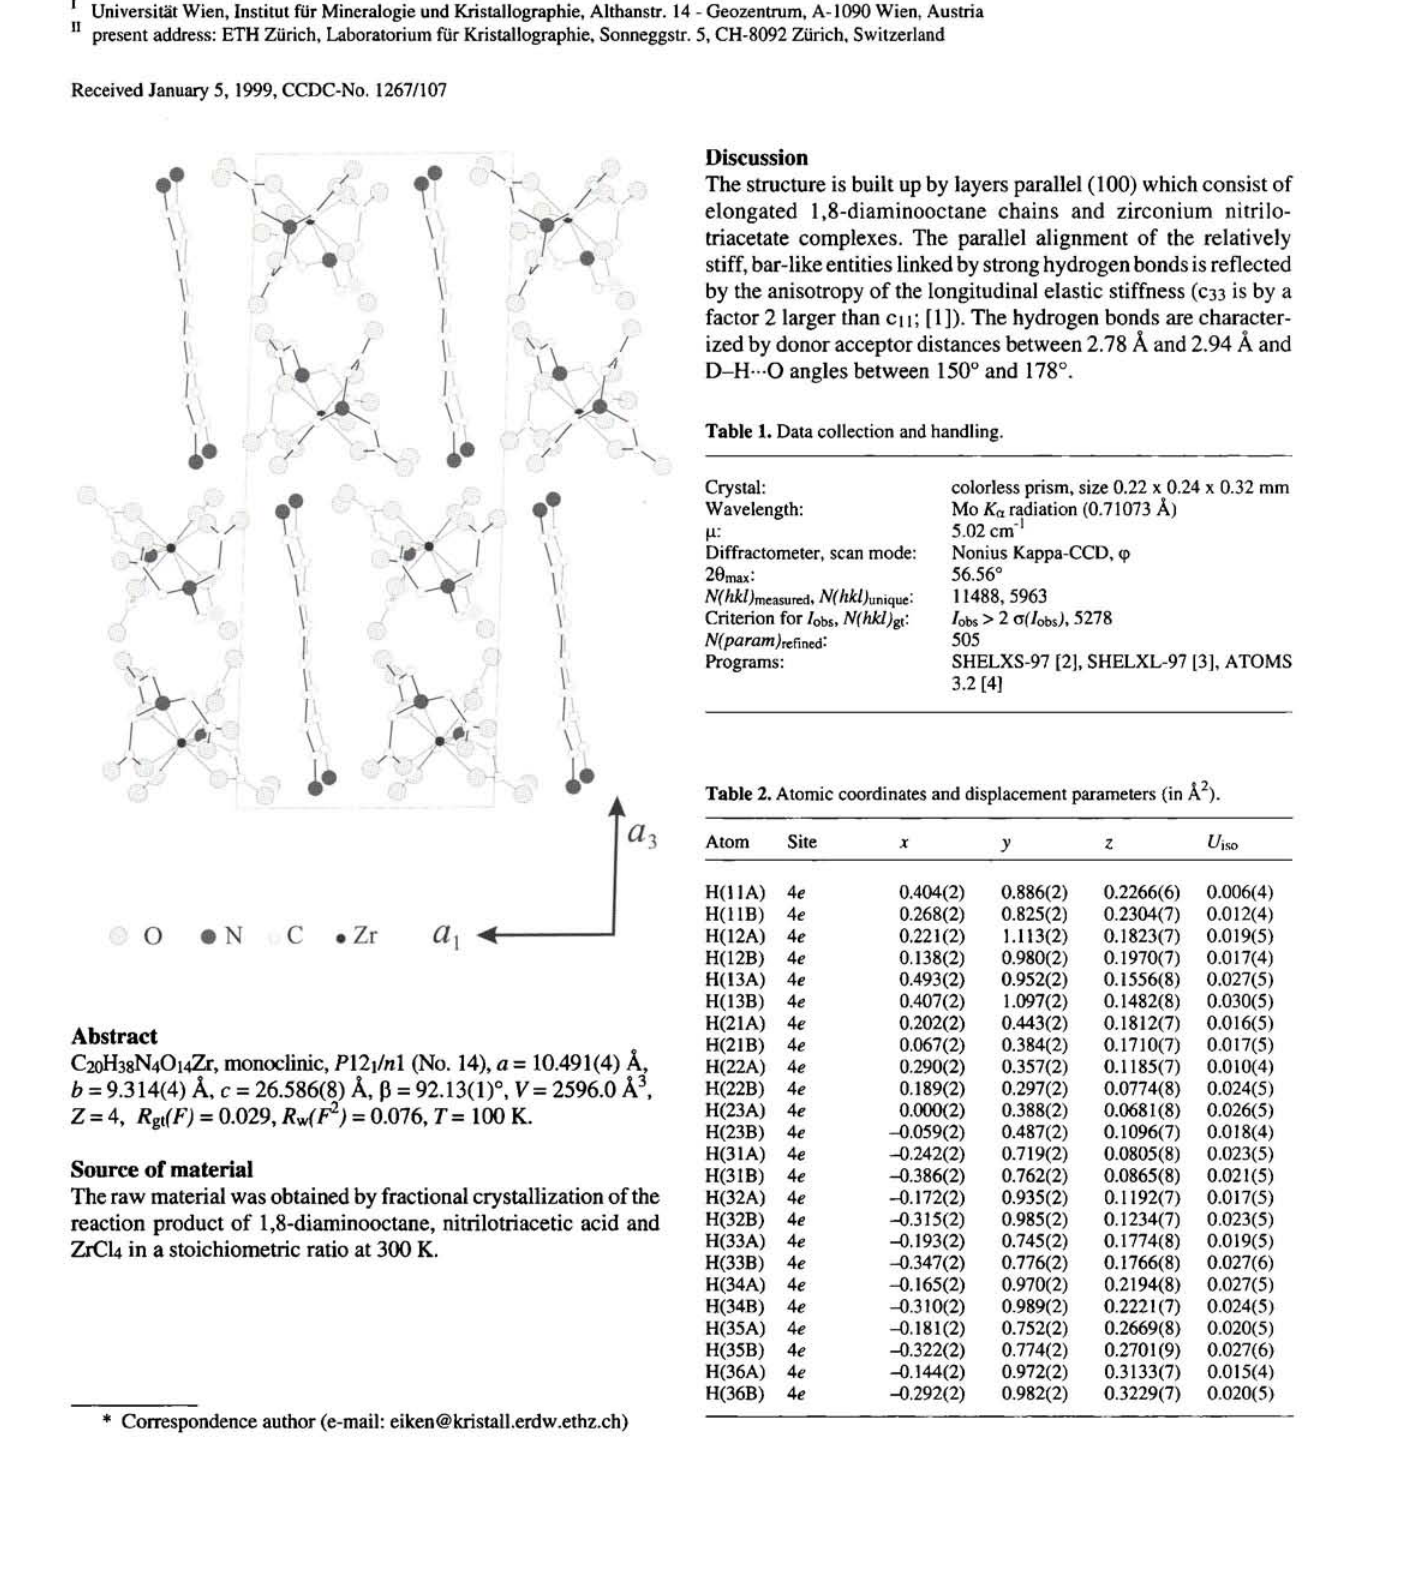
Table 1. Data collection and handling.